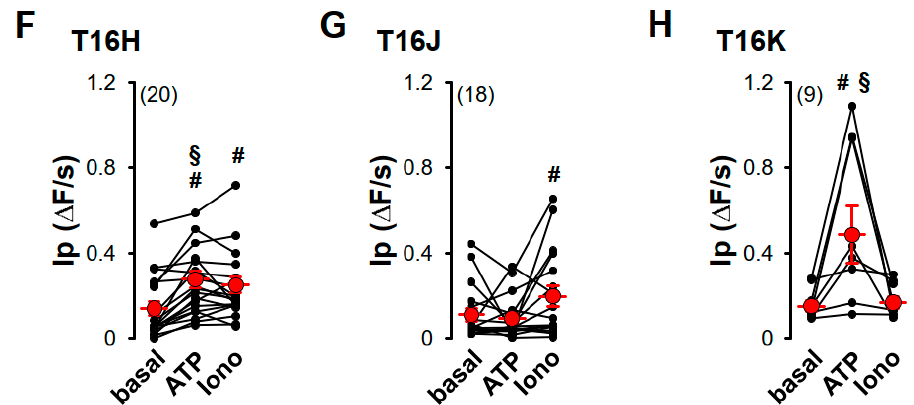
Figure 3. Purinergic stimulation and increase of intracellular Ca 2+ concentration by ionomycin induced iodide permeability in HEK293-YFP cells expressing plasma membrane-targeted TMEM16 proteins. ( A ) Original recording of TMEM16A-CFP-expressing HEK293-YFP cells. Application of 20 mM iodide under control (con) in the presence of 100 µM ATP (ATP) or in the presence of 1 µM ionomycin (Iono) caused in TMEM16A-CFP-expressing HEK293-YFP cells (red, T16A) a strong but in TMEM16A-CFP-non-expressing HEK293-YFP cells (black, mock) only a weak transient quenching of the YFP signal, indicating enhanced iodide permeability through TMEM16A-CFP expression. The Ca 2+ -chelator BAPTA reduced iodide quenching under control conditions in TMEM16A-CFP-expressing HEK293-YFP cells (blue, T16A + BAPTA). ( B ) Original recording of TMEM16K-CFP-CAAX-expressing HEK293-YFP cells (red, T16K). Twenty mM iodide induced a slight increase of the YFP-quenching under control (con) and in the presence of 1 µM ionomycin (Iono), like in TMEM16K-CFP-CAAX-non-expressing HEK293-YFP cells (black, mock) but significantly increased YFP-quenching in the presence of 100 µM ATP when compared to control cells (mock). Summaries of iodide permeability (I P ) measured by initial slope of fluorescence decrease ( Δ F/s) of ( C ) CFP-expressing cells under basal condition (basal), in the presence of 100 µM ATP (ATP) or in the presence of 1 µM ionomycin (Iono); ( D ) of TMEM16A-CFP (T16A)-expressing HEK293-YFP cells under control condition or pre-incubated with 50 µM BAPTA for 30 min at RT; ( E ) TMEM16E-CFP-CAAX (T16E)-, ( F ) TMEM16H-CFP-CAAX (T16H)-, ( G ) TMEM16J-CFP-CAAX (T16J)-, or ( H ) TMEM16K-CFP-CAAX (T16K)-expressing HEK293-YFP cells. (Number of cells measured), # paired t-test, α < 0.05, § unpaired t-test to control and CFP, resepectively, α < 0.05, and analysis of variance (ANOVA) to CFP, α < 0.05.